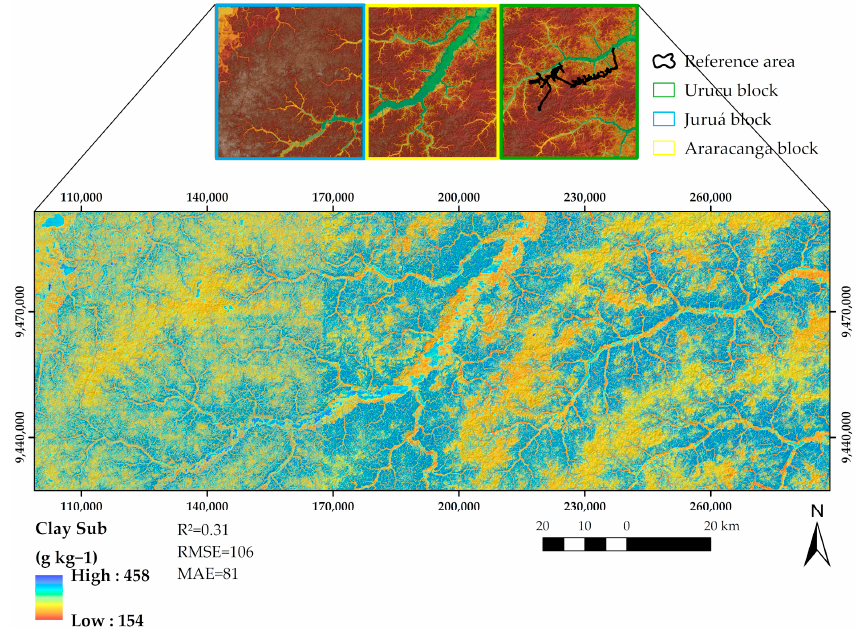
Figure 14. Map of the clay content at the subsurface layer. (Map generated using the Total Area sampling design, Random Forest, and Previous Covariate Selection).